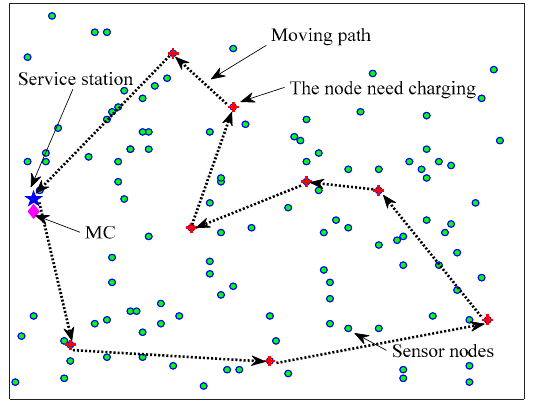
Figure 1. The topology model of network.